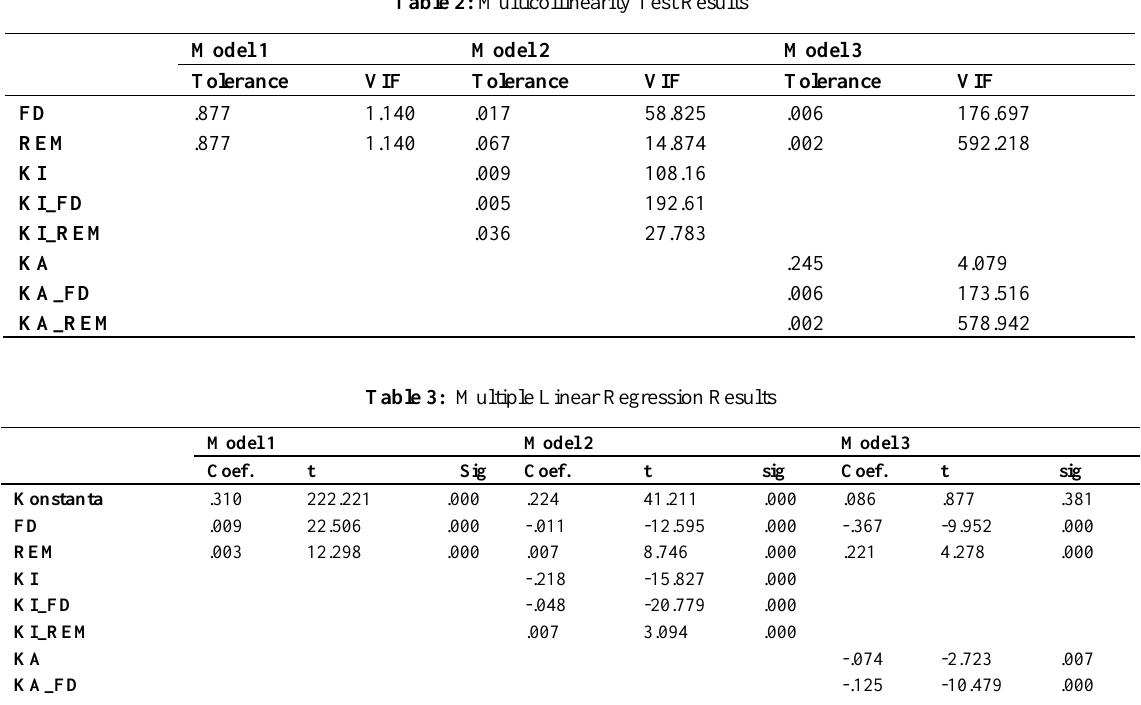
Table 2: Multicollinearity Test Results